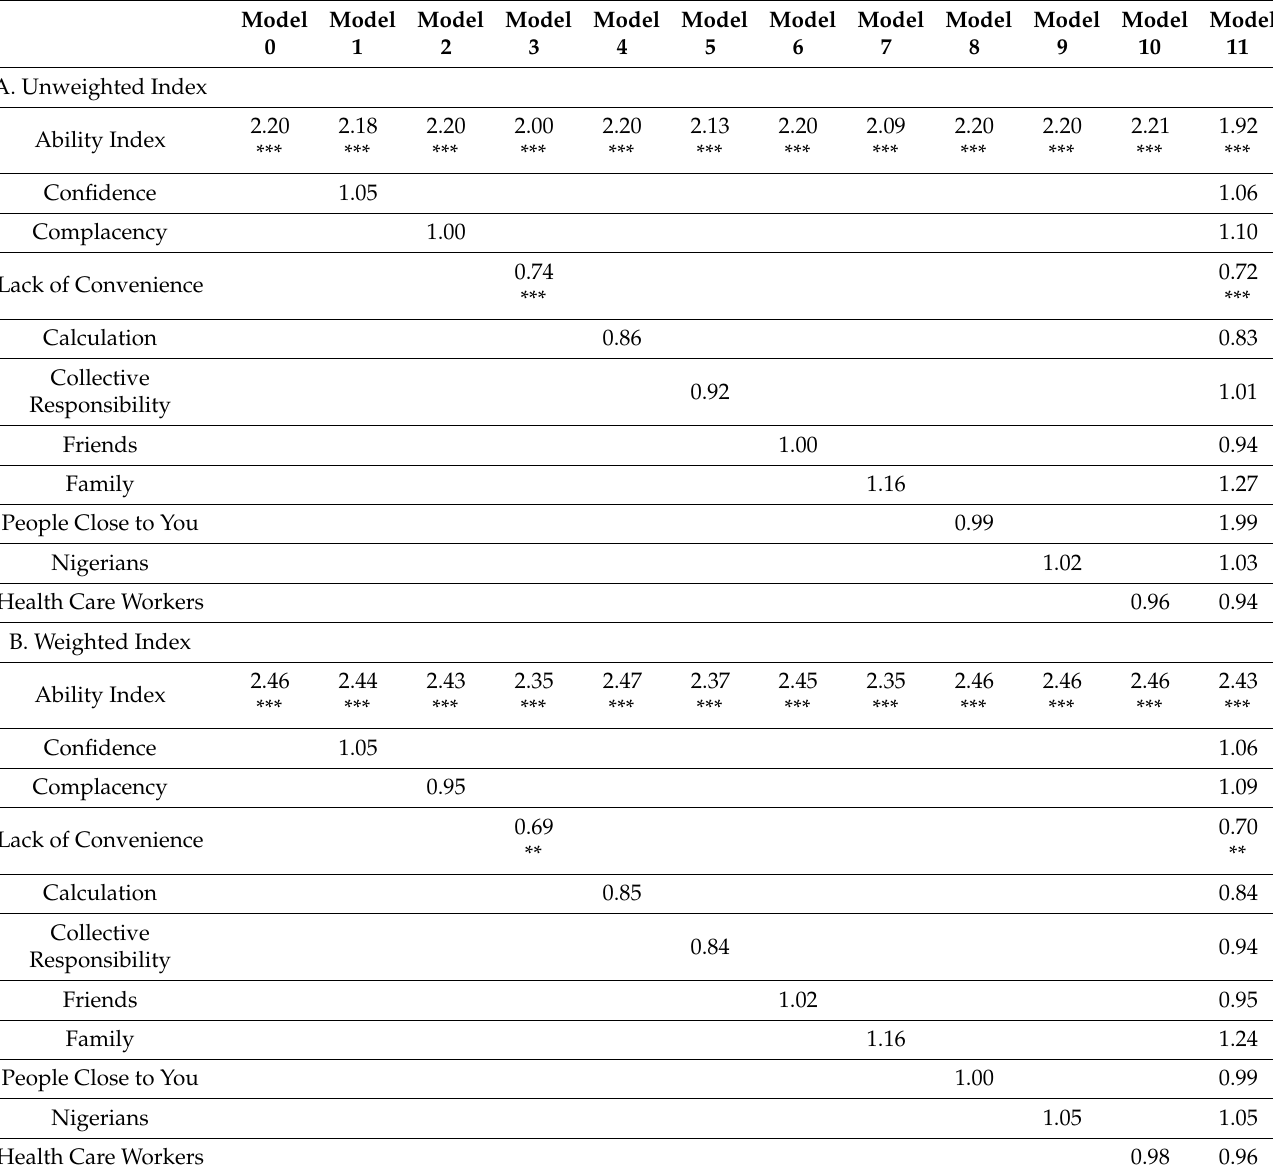
Table 6. Associations of the ability index with vaccination in the holdout sample, without and with control for five Cs and social norms indicators ( n = 395).